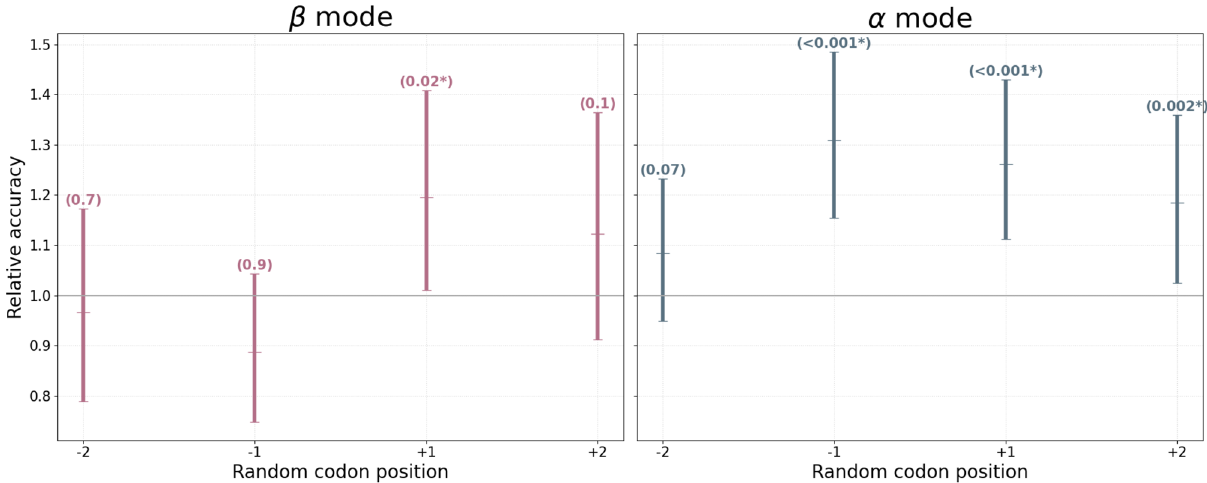
Figure 2. The effect of randomizing synonymous codon identity at different positions, on the prediction accuracy of the synonymous codon identity at the central position. The relative codon assignment accuracy is the comparison between the accuracy using true and random synonymous codons and it is expected that this ratio will be 1 if true and random synonymous codons have equal prediction power, as suggested by the null hypothesis. Mean and 95% confidence intervals were estimated using bootstrapping: the original test set of size = 9575 and N = 3378 was subsampled with replacement to form 10, 000 independent samples of size N α β = 6000 and M = 3000 for the α and β mode respectively. The corresponding p values for rejecting the M α β null hypothesis are listed in parenthesis, and the calculation of the p values is explained in greater detail in the “Methods”.